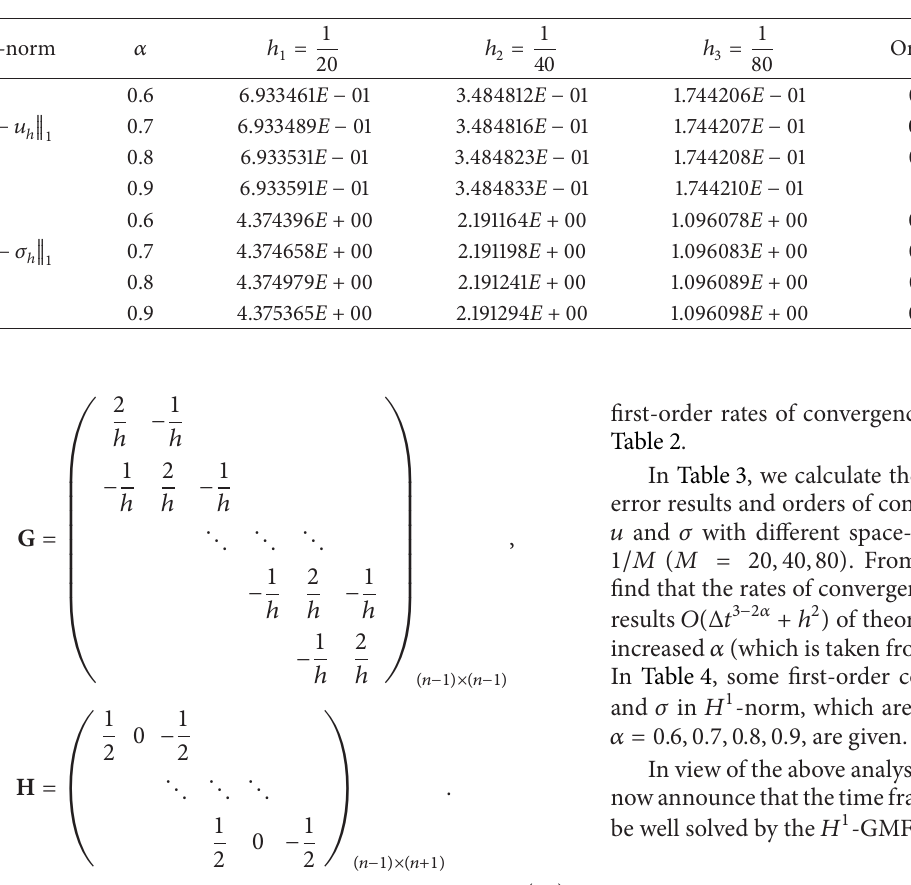
Table 2: Spatial convergence results in 𝐻 1 -norm with fixed Δ𝑡 = 1/4000 and changed 𝛼